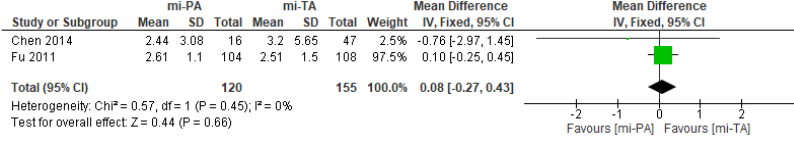
Figure 3. Cumulative analysis of eligible studies comparing mi ‐ PA vs. mi ‐ TA in terms of ( a ) complete clinical success according to PASO criteria, ( b ) partial clinical success according to PASO criteria, ( c ) absent clinical success according to PASO criteria, ( d ) no ‐ standardized complete clinical